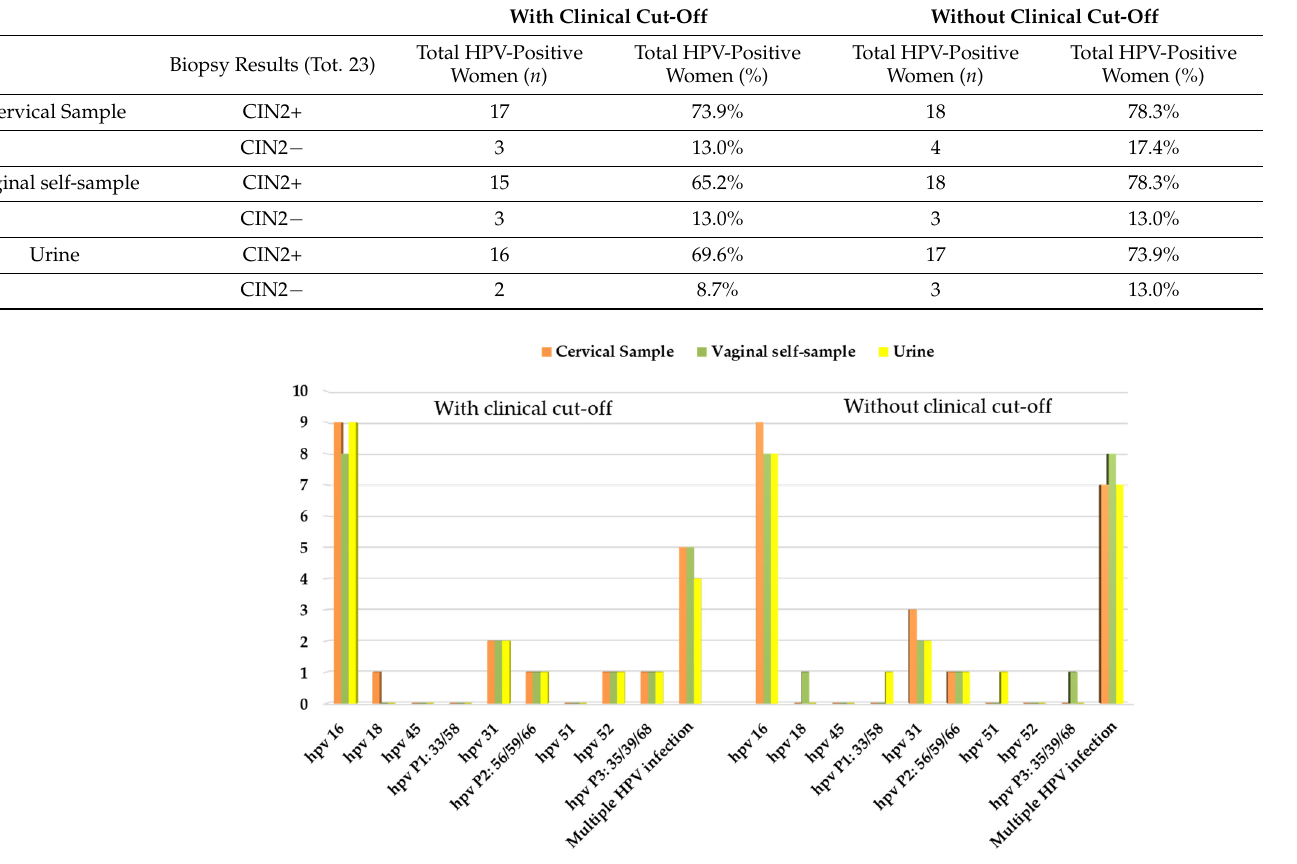
Figure 3. HPV genotypes' distribution among women with abnormal colposcopy findings.